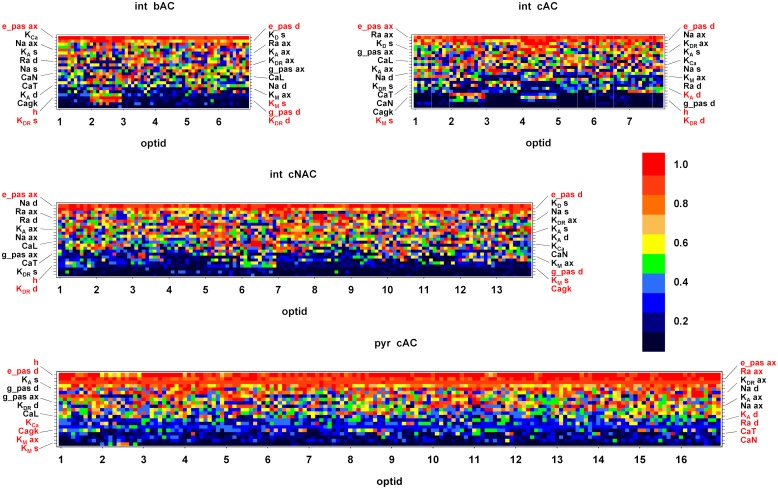
Degeneracy in CA1 pyramidal neurons.Optimized values for all parameters, obtained for the 10 best individuals from each optimization. The X-axis represents the individual optimizations (each composed by 10 individuals), the Y-axis is the parameter’s name. The pixel colors represent the value of the parameter, normalized to the maximum value obtained from all optimizations of a given e-type. The color scale is shown on the right. Abbreviations as in Fig 4. In all cases the total error was in the range of 29–42 sd.